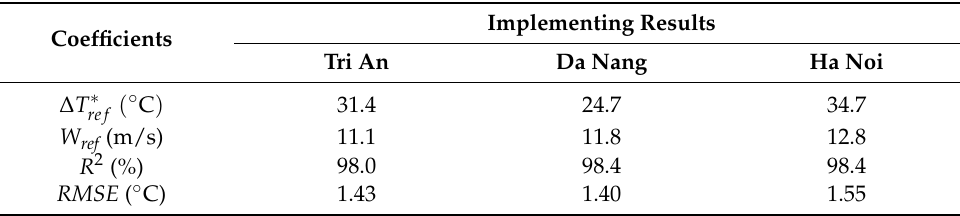
Table 6. Correlation coefficients ( R 2 and RMSE ) for measured and calculated module temperatures for three regions in Vietnam using optimal coefficients (5-min time step).